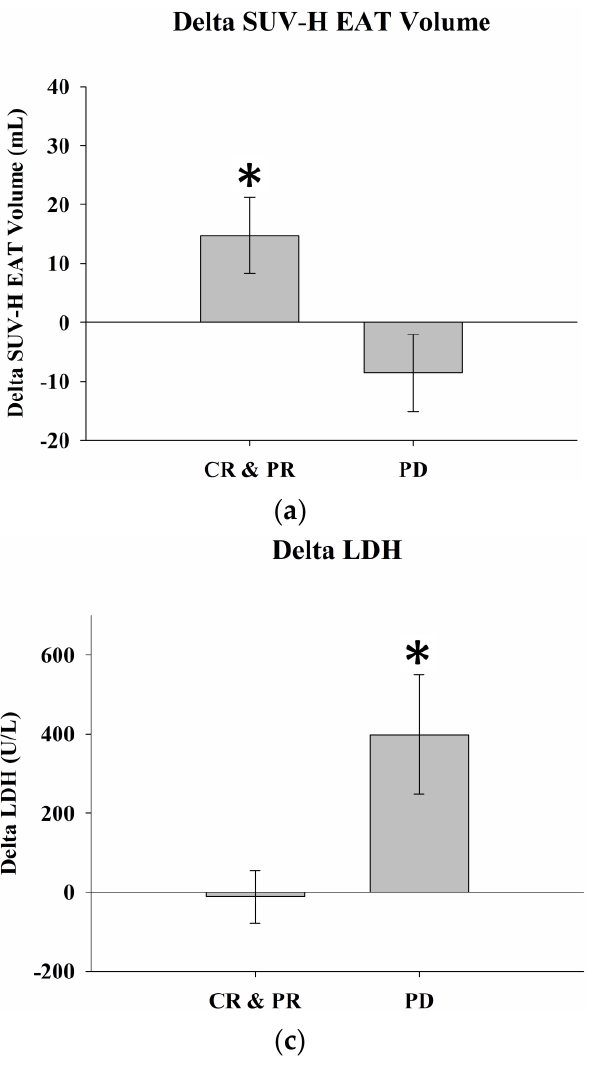
Figure 4. Delta SUV-H EAT, OAT volumes, serum LDH levels, and BMI with different treatment responses. ( a ) Greater delta SUV-H EAT volume was observed in responders than in non-responders ( p = 0.03). ( b ) There was significantly more delta SUV-H OAT volume detected in responders than in non-responders ( p = 0.001). ( c ) A significantly higher delta LDH level was noted in non-responders than in responders ( p = 0.03). ( d ) There was no significant difference in delta BMI between responders and non-responders ( p = 0.36). * Differences are significant at the 0.05 level (two-tailed). ** Differences are significant at the 0.01 level (two-tailed). SUV-H EAT, high standardized uptake value epicardial adipose tissue; SUV-H OAT, high standardized uptake value orbital adipose tissue; LDH, lactate dehydrogenase; BMI, body mass index; CR, complete response; PR, partial response; PD, progressive disease.